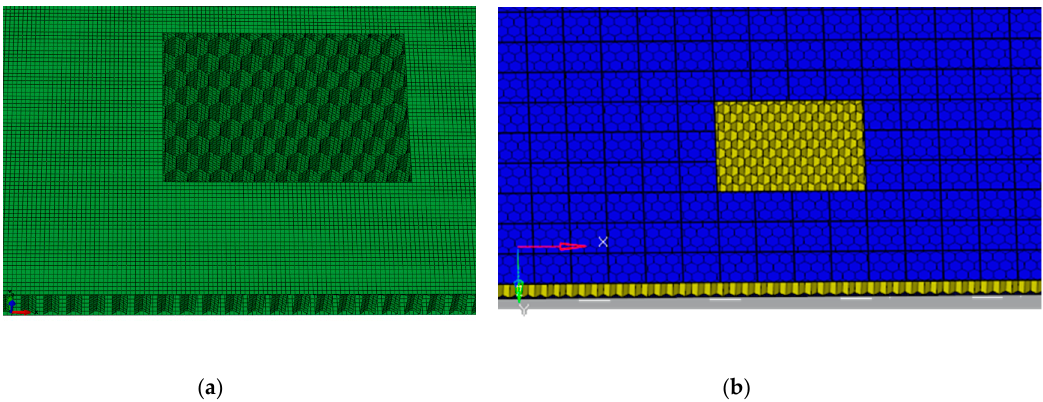
Figure 10. Schematic of the finite element model of honeycomb sandwich structure: ( a ) h element mesh; ( b ) p element mesh.